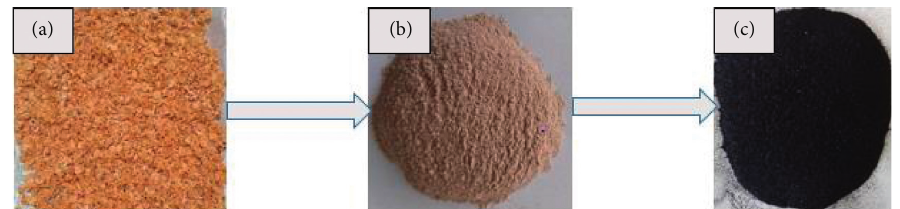
Figure 1: Lupinus albus seed peel waste (a), powdered Lupinus albus seed peel waste, RLAPW (b), and physicochemically activated Lupinus albus seed peel waste, ALAPW